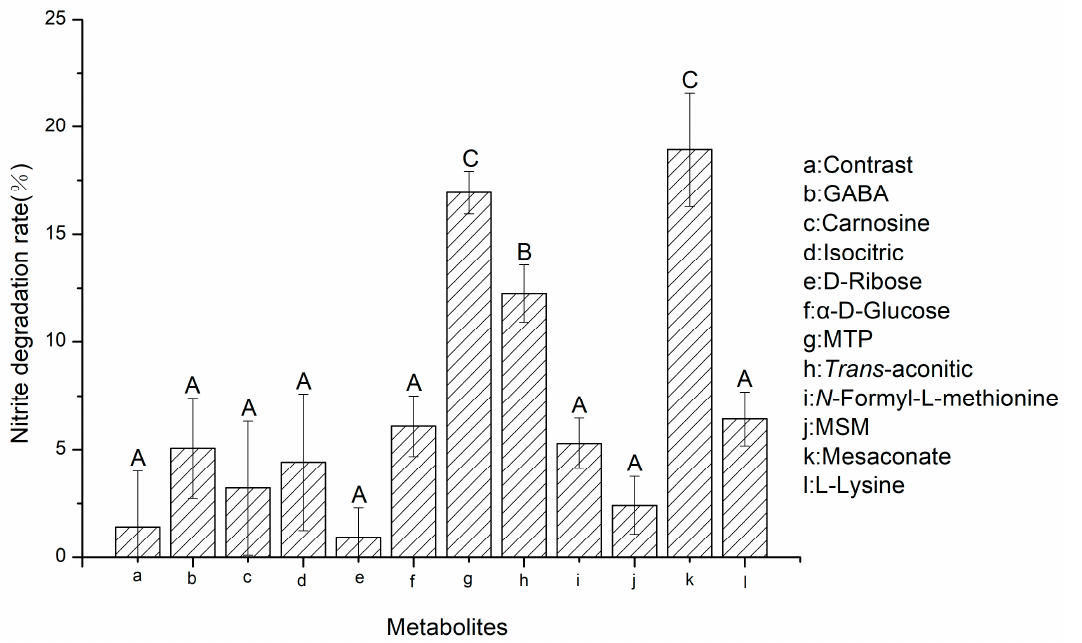
Figure 6. A histogram of nitrite degradation by target metabolites in 24 h. Note: A-C represent that there are significant differences between metabolites with different letters, p ≤ 0.05.